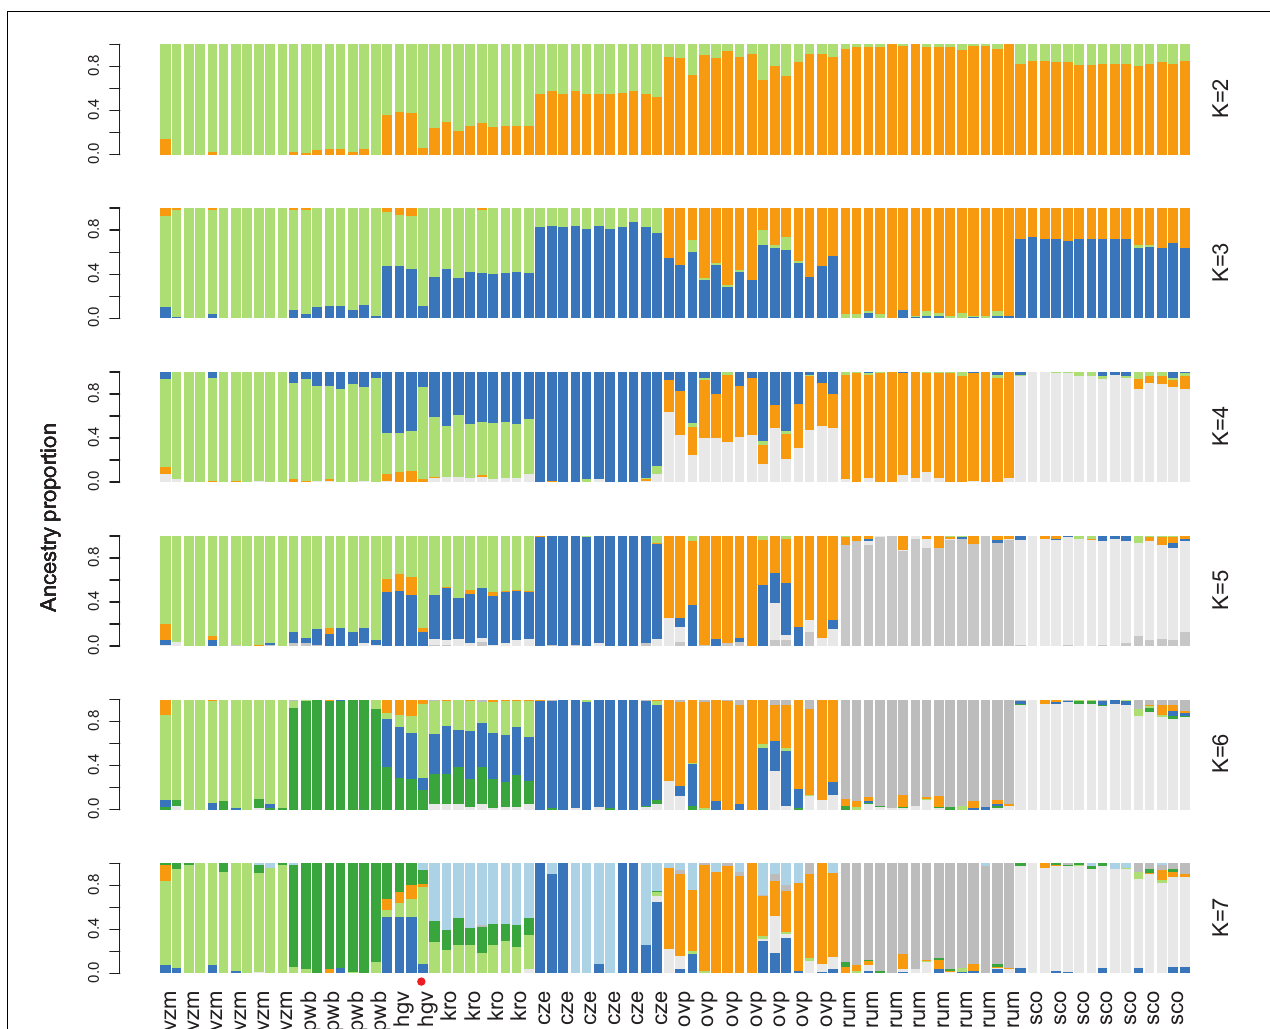
FIGURE 3 | Ancestry analysis of red deer focal and reference populations, at K = 2 to K = 7. The most likely number of K clusters lies within the range 2 to 4 ( Supplementary Figure 6 ). Each vertical bar represents one individual. The red dot indicates the putative migrant. Population abbreviations and sample sizes are as follows: Of the autochthonous relic populations: vzm, Veluwezoom (11); pwb, Planken Wambuis (8); of the allochthonous estate populations: hgv, Hoge Veluwe (4) and kro, Kroondomeinen (9), of the allochthonous rewilding population: ovp, Oostvaardersplassen (15); and the reference populations: cze, Czechia (11), rum, Isle of Rum (15), sco, mainland of Scotland (15). For populations with more than 15 samples, 15 individuals were randomly